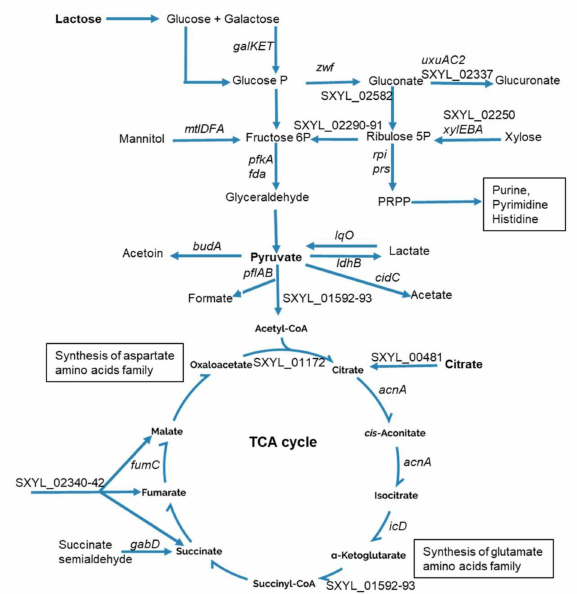
Figure 1. Summary of carbohydrate catabolism by Staphylococcus xylosus in solid dairy matrix showing the overexpressed genes (the level of expression of these genes and the name of the corresponding enzymes are given Table